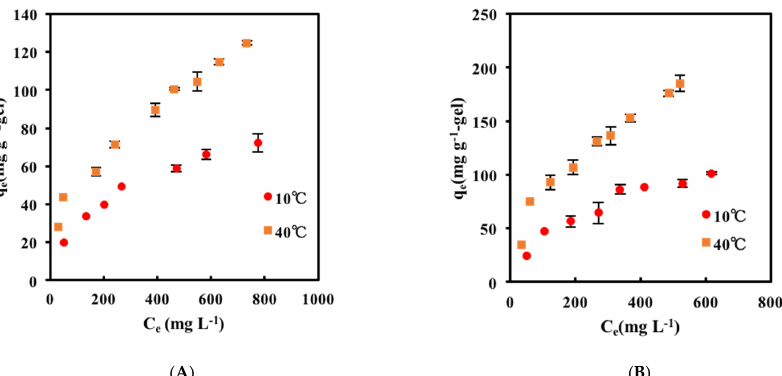
Gels 2021 , 7 , x FOR PEER REVIEW